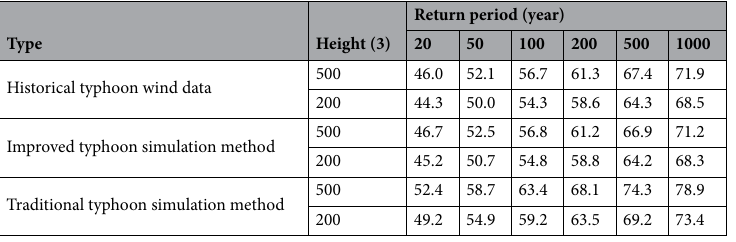
Table 4. Typhoon extreme wind speeds under different return periods in Hong Kong (m/s).